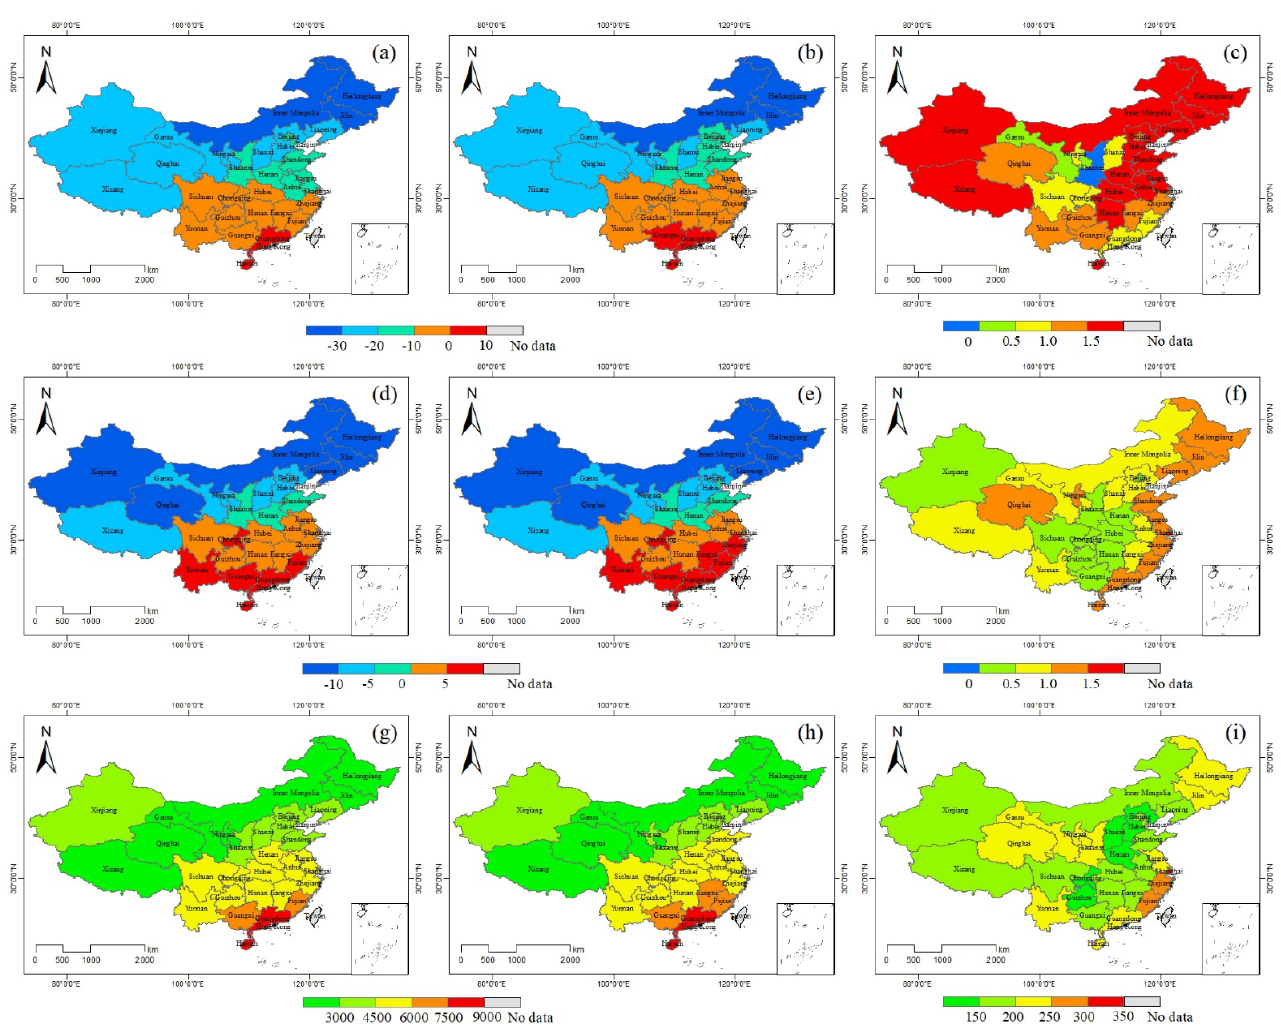
Figure 4. The extreme minimum temperature (the first row: ( a–c )), mean minimum temperature in the coldest month (the second row: ( d–f )) and accumulated temperature with daily mean temperature greater than or equal to 10 °C (the third row: ( g–i )) of each province during 1961 – 1990 (the first column: ( a , d , g )) and 1991 – 2020 (the second column: ( b , e , h )), along with their difference (the third column: ( c , f , i )).